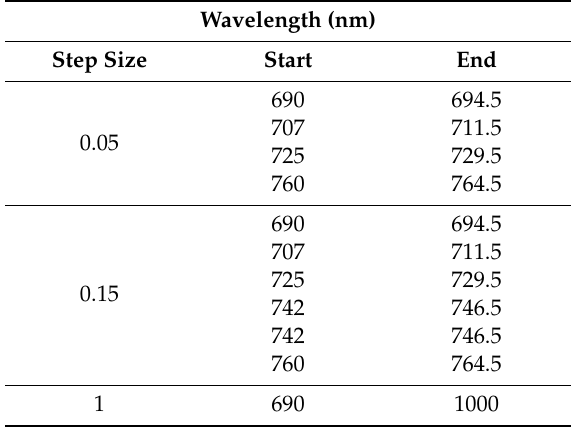
Table 2. Goddard’s laser for absolute measurement of radiance (GLAMR) observations of